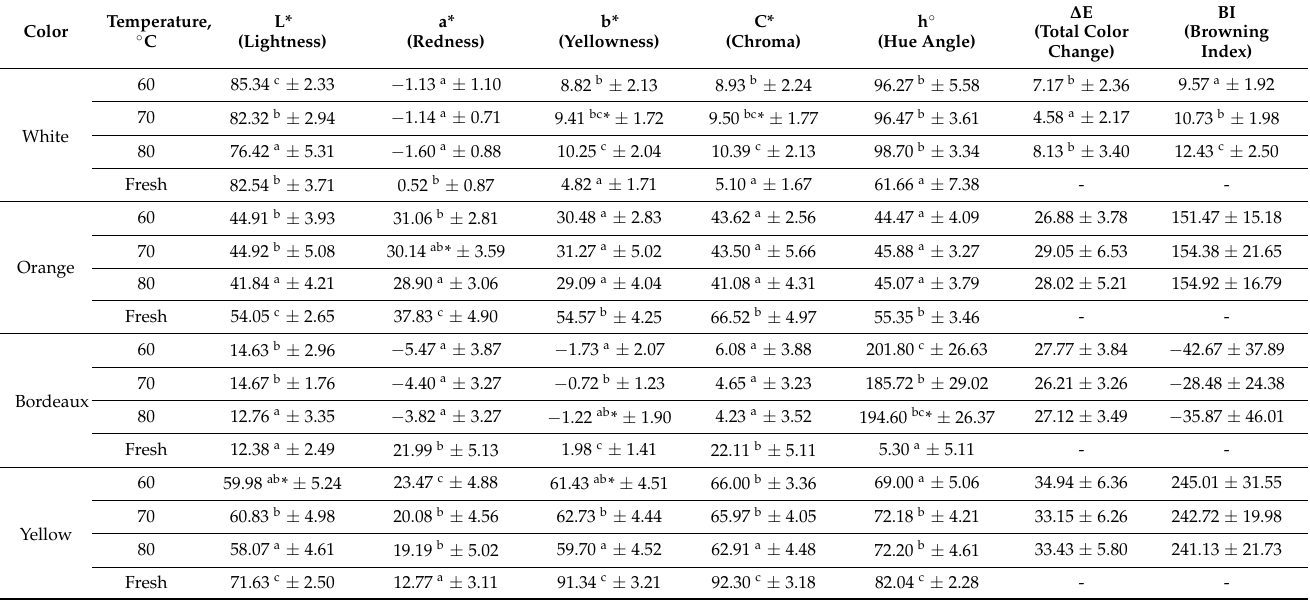
Table 1. Color characteristics of pansy flowers of different colors dried at different